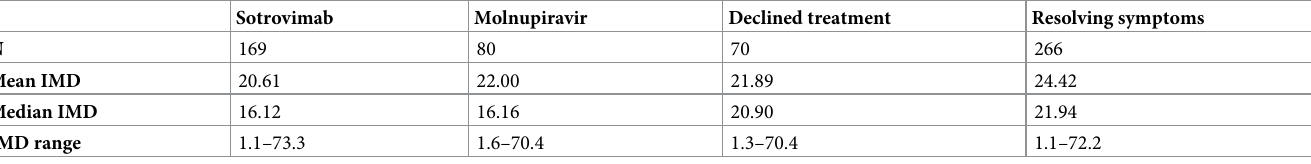
Table 4. Index of multiple deprivation data of patients referred to the Covid medicines delivery